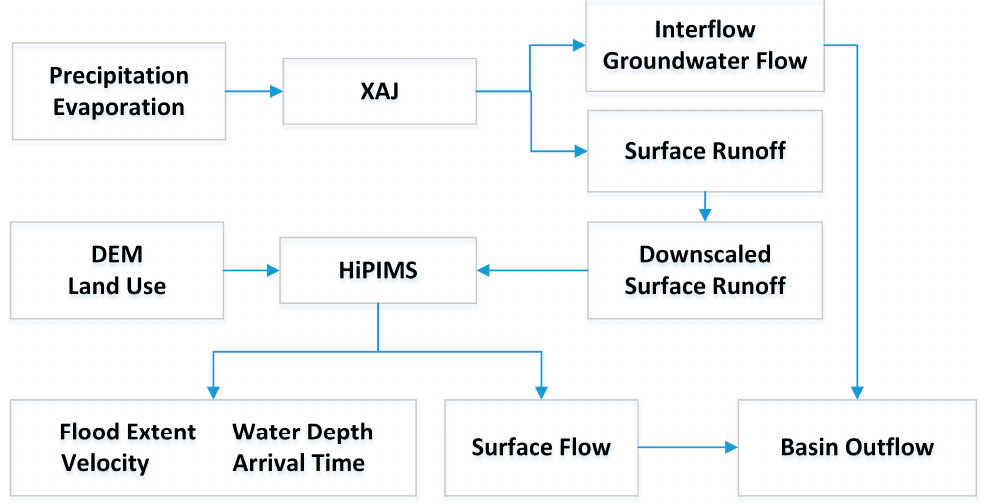
Figure 2. Flowchart of the coupling framework.